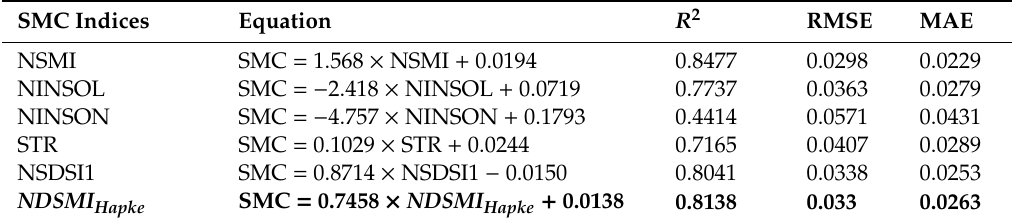
Figure 15. Linear fitting of the six moisture indices and VWC using the calibration data. Table 5. Comparison of the SMC accuracy.